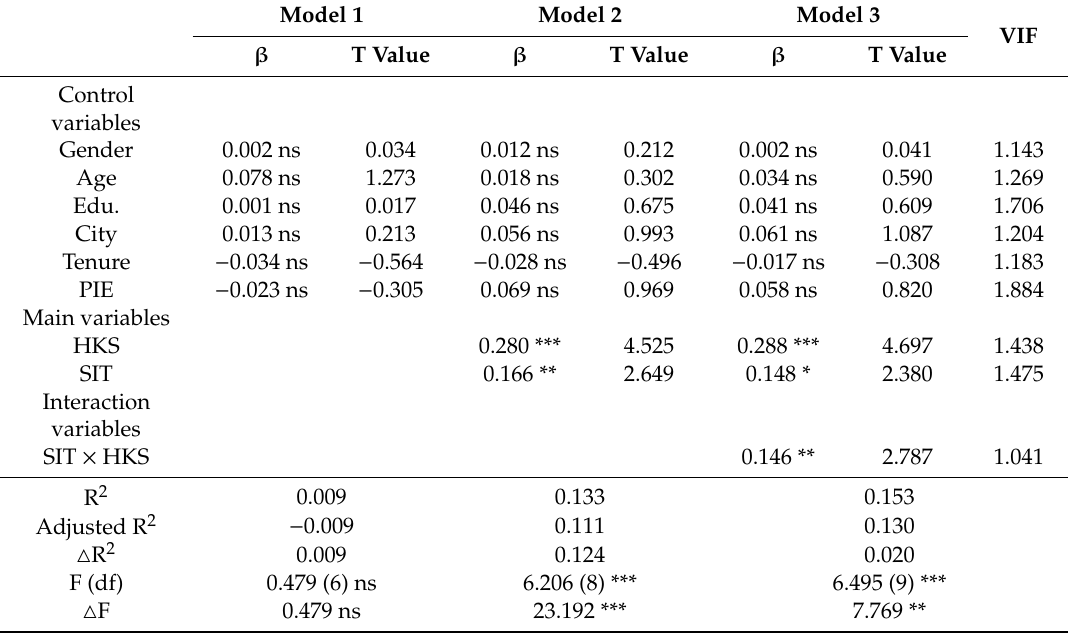
Table 6. Results of hierarchical